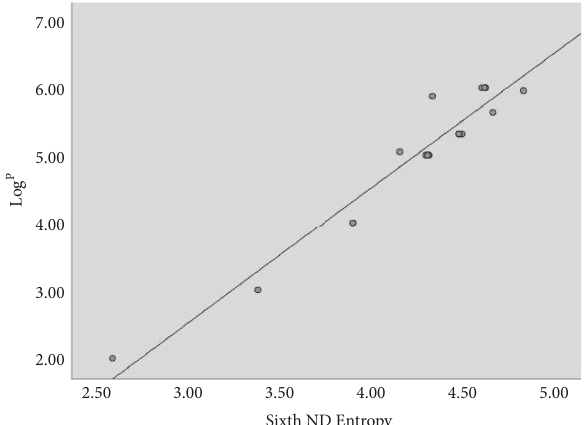
Figure 9: Graphical representation of LRM between log ( P ) and the sixth ND